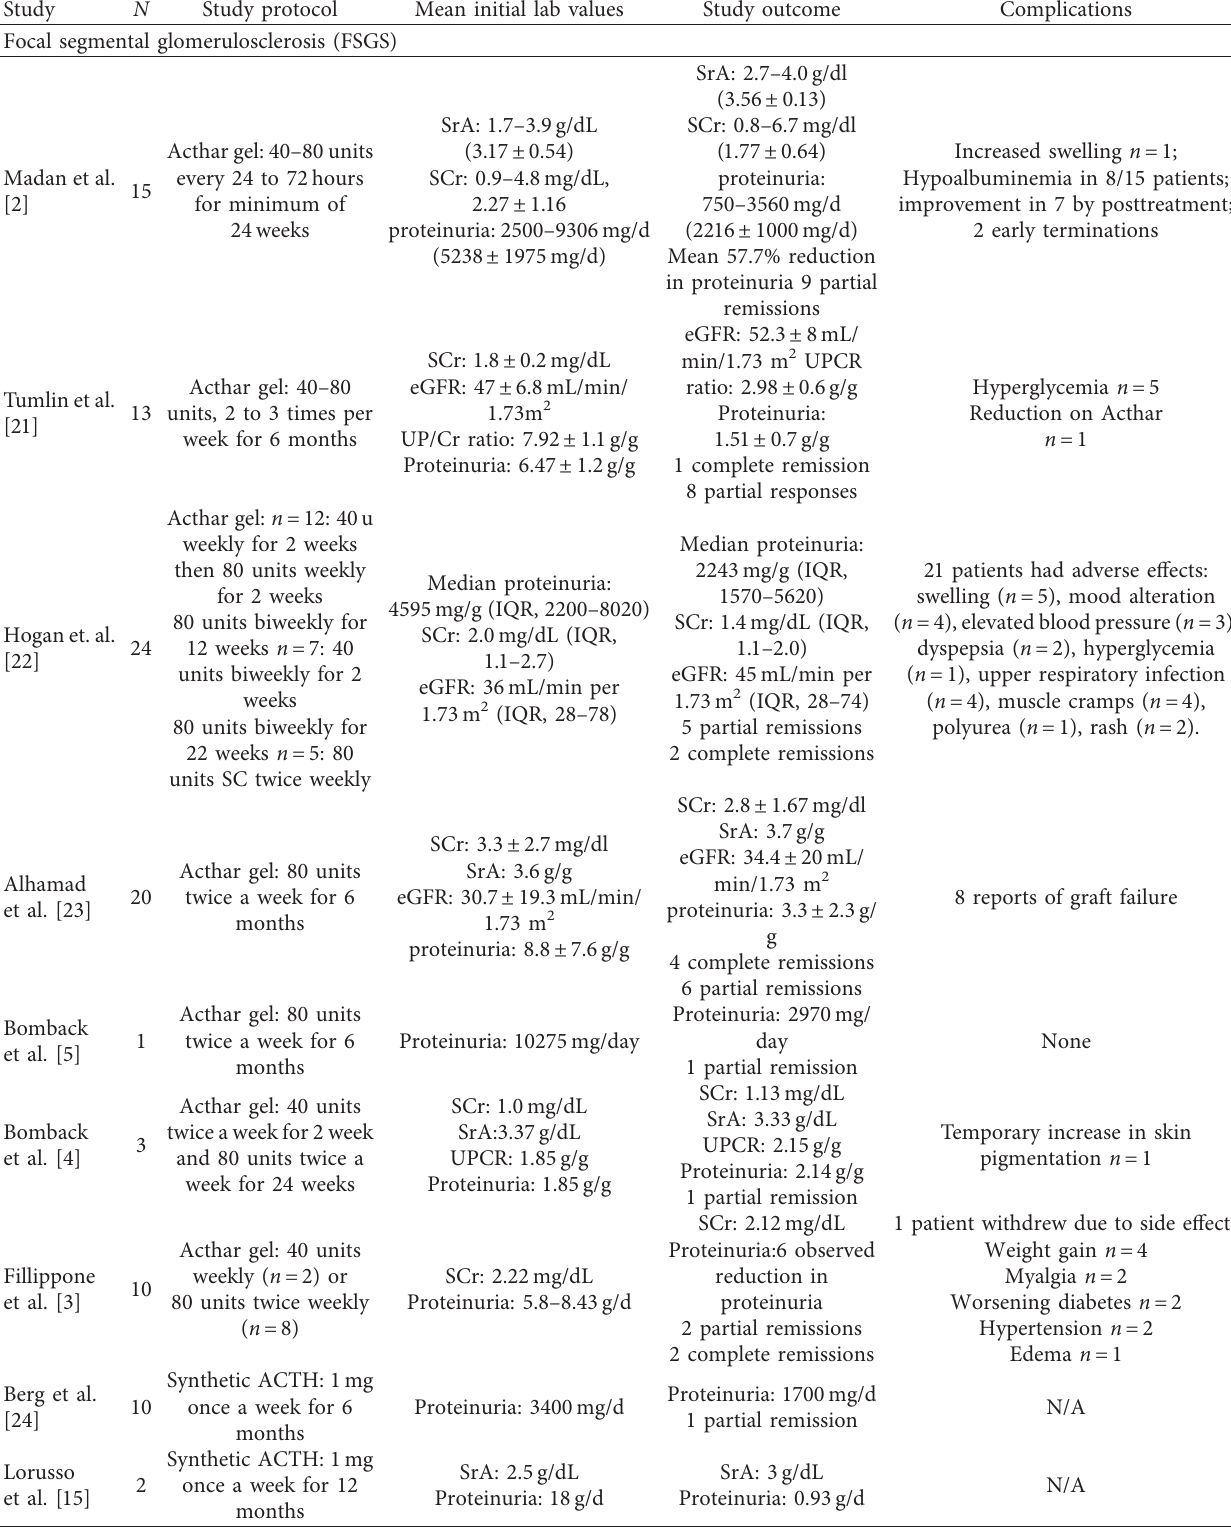
Table 6: Summary of studies on ACTH in focal segmental